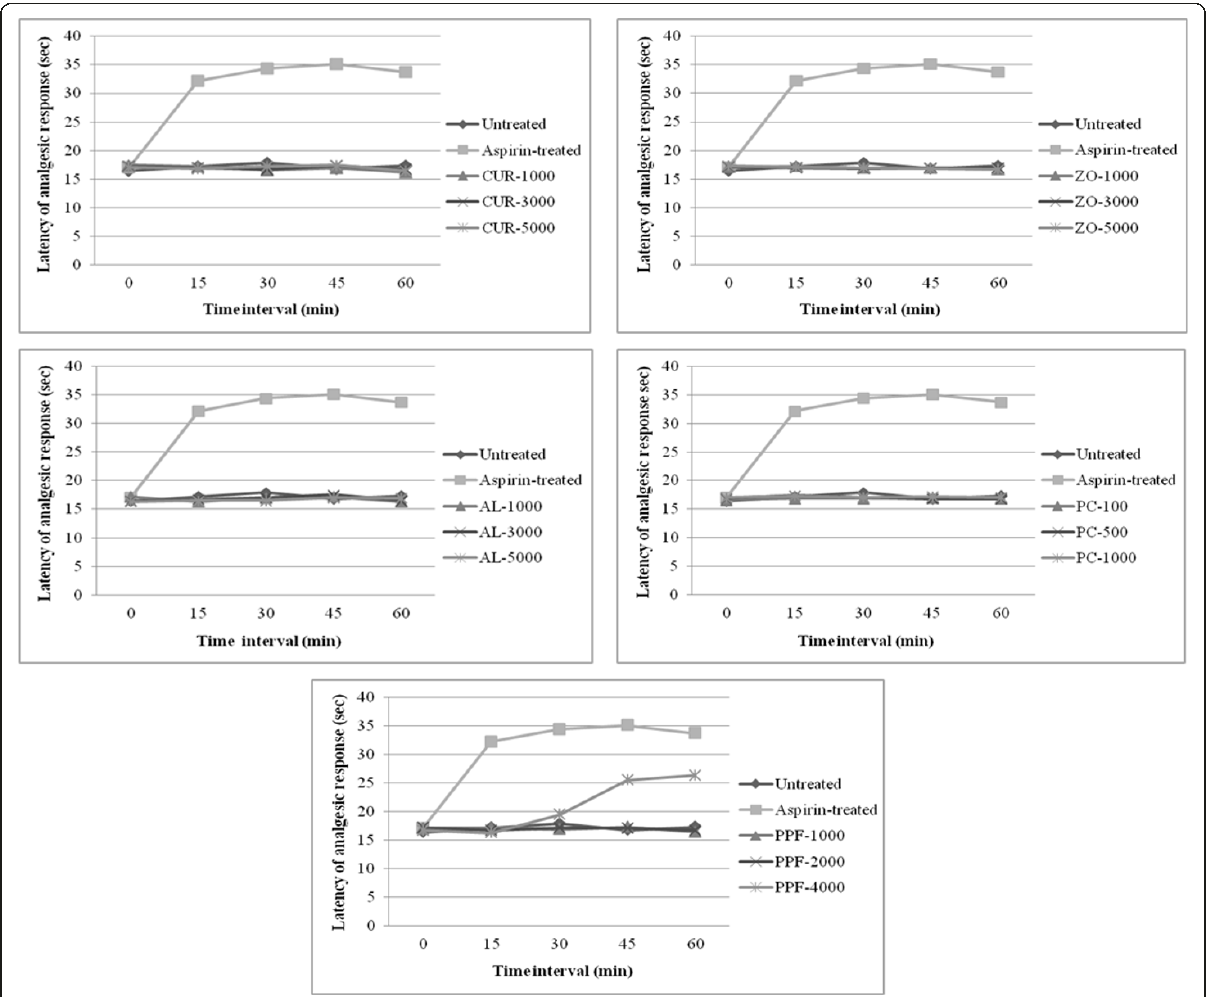
Figure 6 Central analgesic activity (represented by mean ± SEM of analgesic response in hot plate test) of CUR compound and extracts of ZO, AL, PC, and PPF at various dose levels, in comparison with untreated control and aspirin (reference control) . Statistically significant difference by ANOVA, followed by post hoc scheffe test: PPF-treated group at high dose level vs. control group (p < 0.01). Aspirin- treated group vs. control group (p <